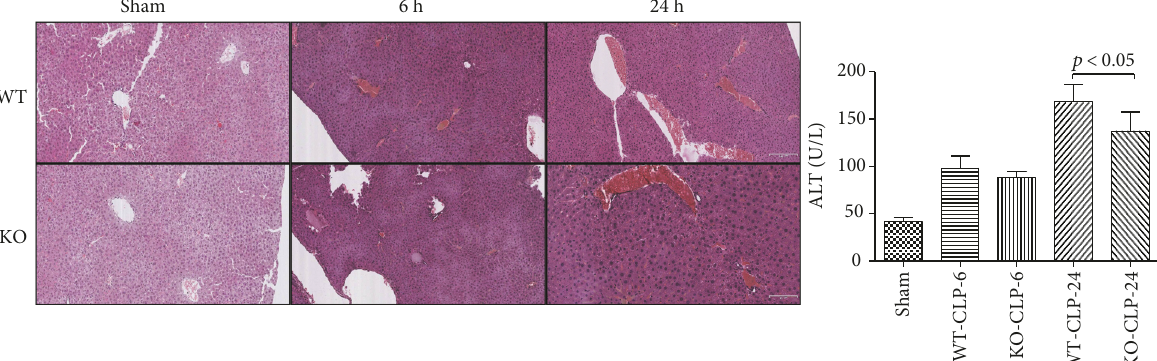
Figure 5: Lack of 5-HT alleviates histopathology damage and organ dysfunction in the liver in CLP-induced sepsis in mice. The animal blood samples and liver tissues were harvested at 6h or 24h after the CLP administration. H&E staining was conducted as described above. In the liver, the WT mice showed a marked congestion, in fl ammatory cell in fi ltration, necrosis, and degeneration. The KO-CLP mice had alleviated histopathological changes. ALT was calculated as an assessment of liver dysfunction ( n = 6 , ALT: mean ± SD, p < 0 05 versus the WT-CLP group at 24h after the CLP administration).